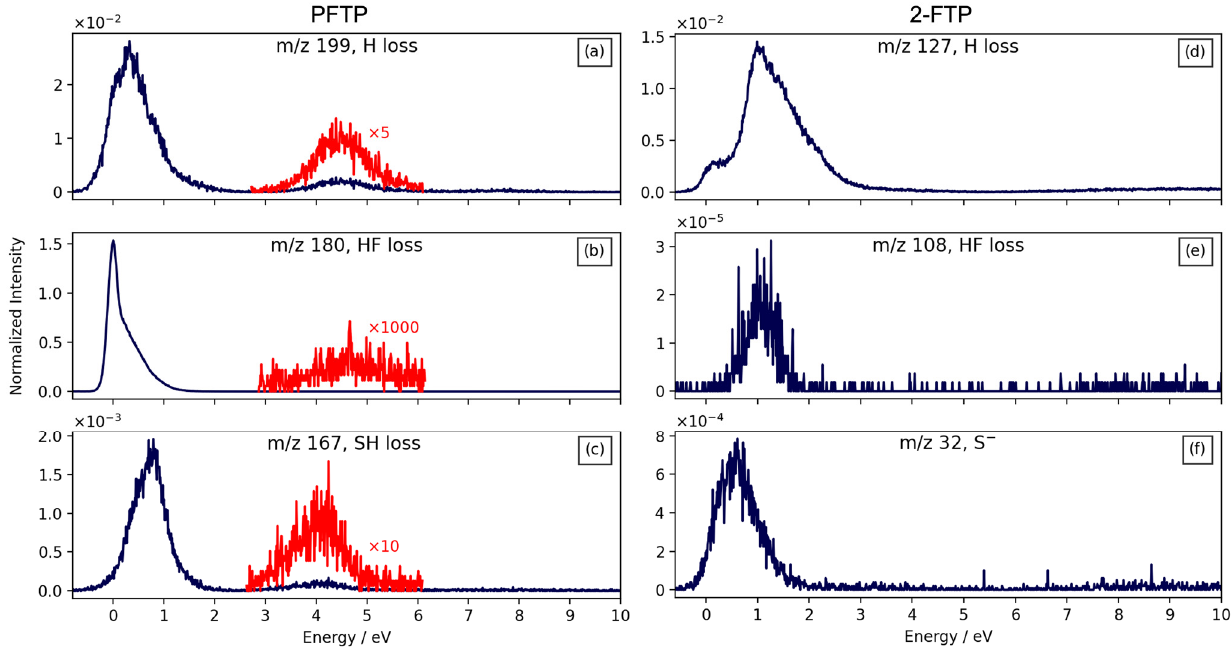
Figure 1. Left: DEA ion yield curves from PFTP for the channels: ( a ) H loss, ( b ) HF loss, and ( c ) SH loss. Right: DEA ion yield curves from 2-FTP for the channels: ( d ) H loss, ( e ) HF loss, ( f ) S − formation. The intensities are normalized with respect to the target gas pressure and the formation of SF 6 − from SF 6 at 0 eV incident electron energy.